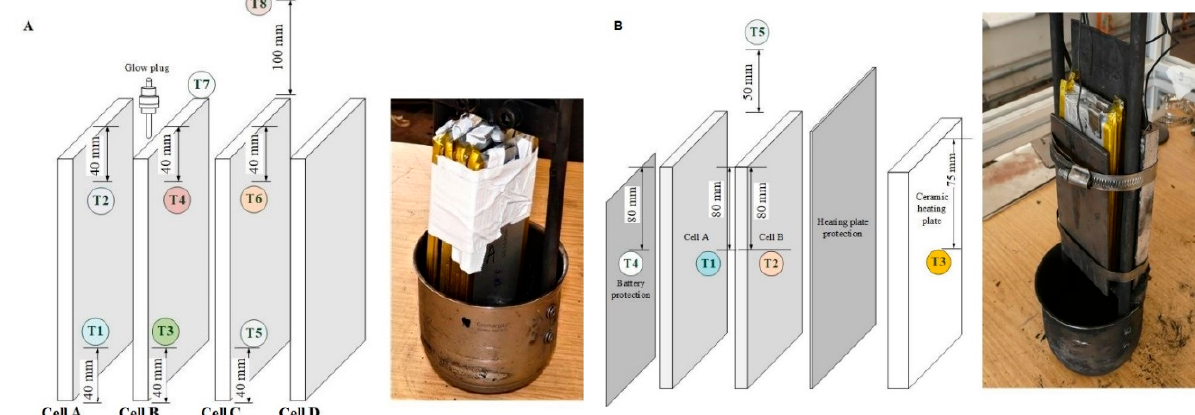
Figure 6. Positioning of thermocouples on the: ( A ) 4-cell battery stack; ( B ) double cells. Thermal runaway was triggered by local overheating of the cells using two different heat sources: a glow plug in Series 1 tests and a heating plate in Series 2 The connected voltage regulator PS (Voltcraft SPS 1540 PFC, Wels, Austria) and the transformer TF (Thalheimer LTS 606 Isolation Transformer, Ellwangen (Jagst, Germany) were used to maintain the power supply to the respective heat source used, see Figure 5B.